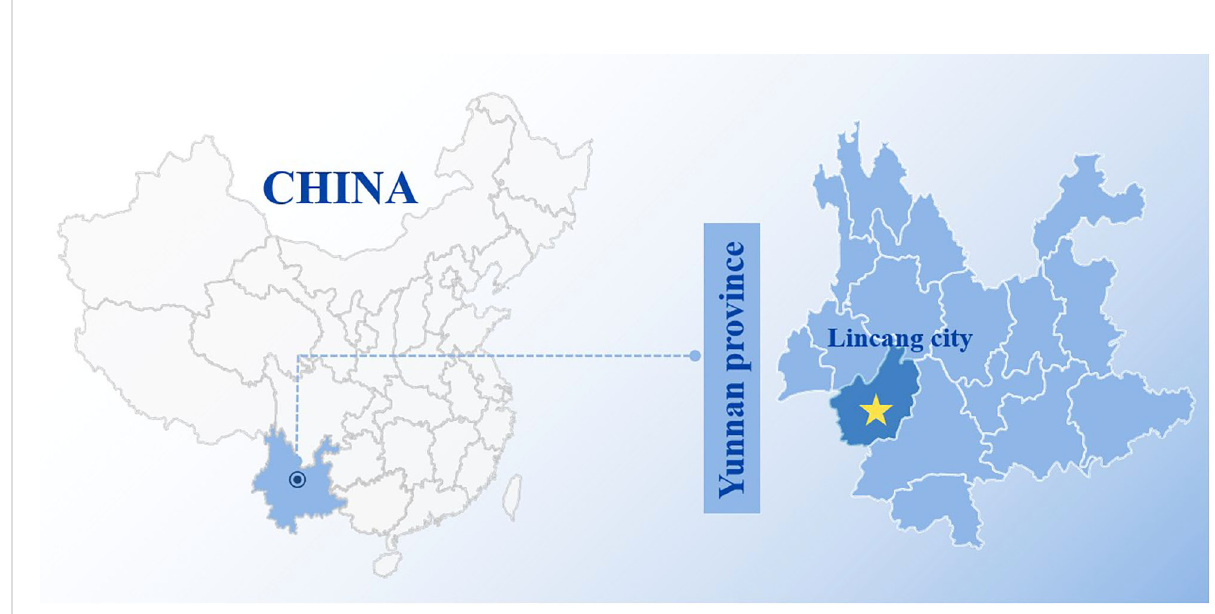
FIGURE 1 The sample collection site in Yunnan province, China. The sample collection site was labeled with yellow solid